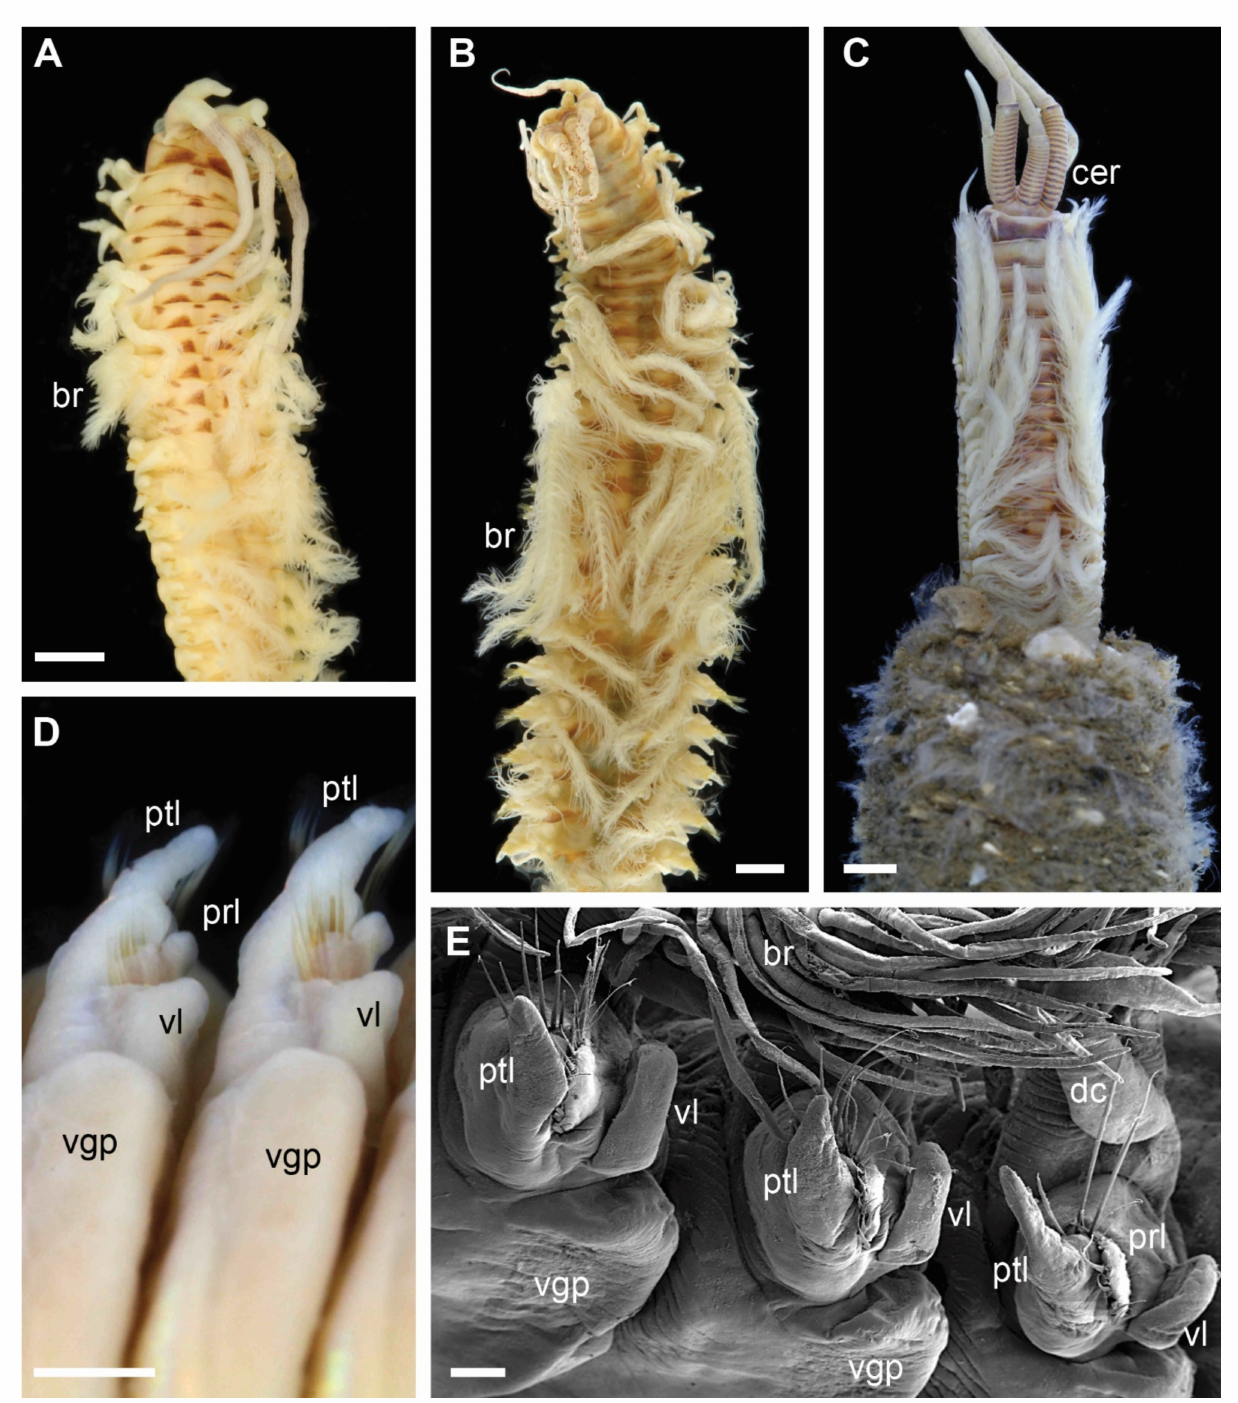
Figure 2. Morphology of Diopatra species representing Clade 1. ( A – C )—light microscopy pho- tographs; ( E )—scanning electron microscopy image. ( A ): Diopatra sp. 1 ZMBN91384, anterior frag- ment showing color pattern, dorsal view; ( B ): Diopatra sp. 4 ZMBN91381, anterior fragment showing well-developed branchiae, dorsal view; ( C ): Diopatra sp. 2 ZMBN91368, anterior fragment showing nu- merous rings on ceratophores, dorsal view; ( D ): Diopatra neapolitana ZMH P-13819, anterior parapodia showing the presence of ventral lobes, ventral view; ( E ): Diopatra sp. 4 ZMBN91380, anterior parapo- dia showing the presence of ventral lobes, lateral view. br—branchia; cer –ceratophore; dc—dorsal cirrus; prl—prechaetal lobe; ptl—postchaetal lobe; vgp—ventral glandular pad; vl—ventral lobe. Scale bars: ( A – D )—1 mm; ( E )—100 µ